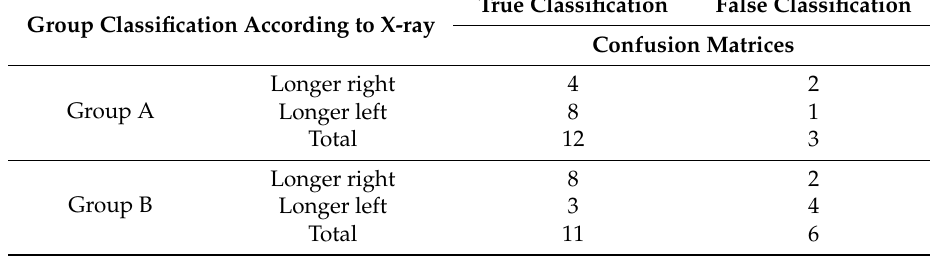
Table 3. Classifier performance.